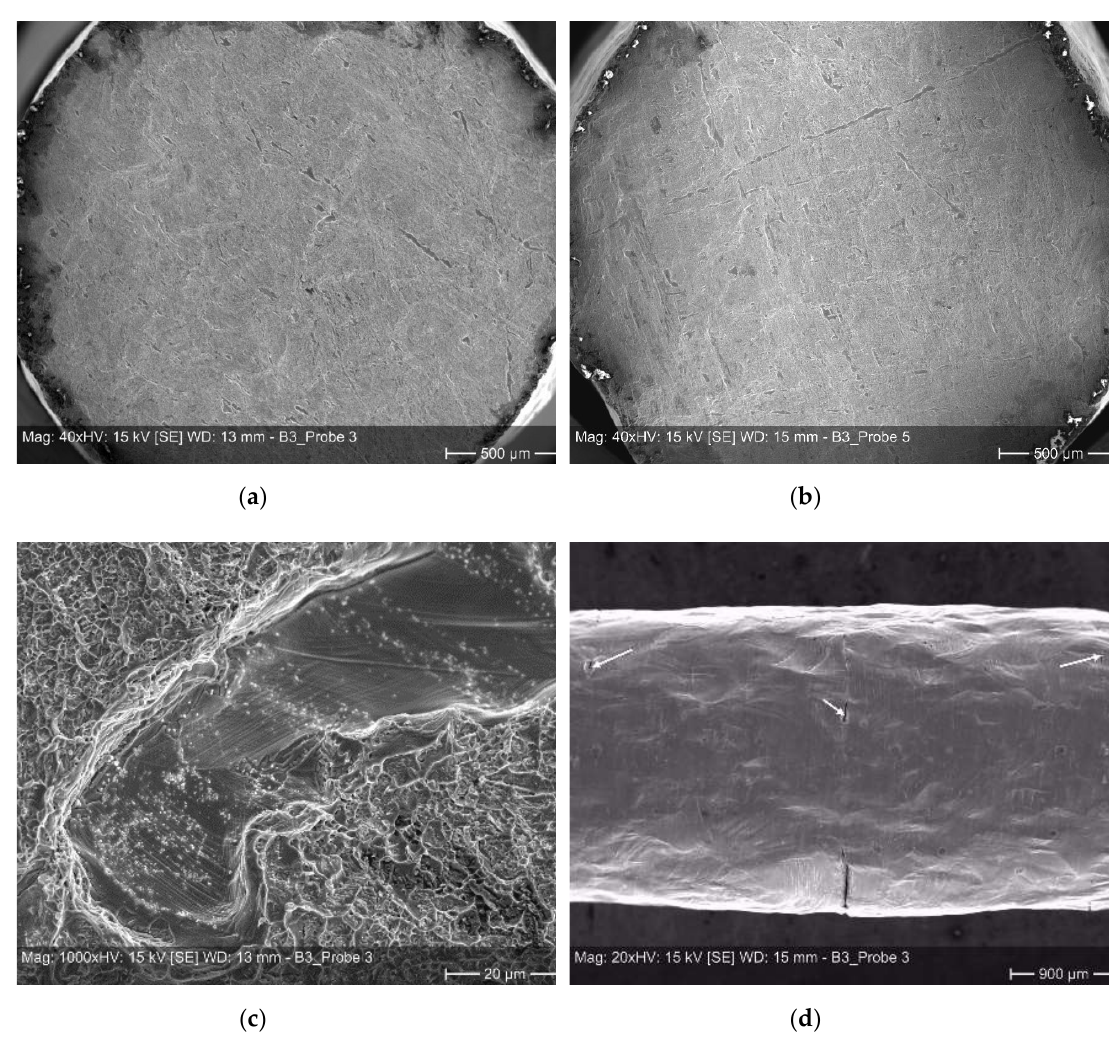
Figure 9. Micrographs of tensile tested diffusion bonded samples–( a ) and ( b ): overview of fracture surfaces; ( c ): ductile fracture area surrounding a weak spot; and ( d ): small surface cracks located at different bonding planes.